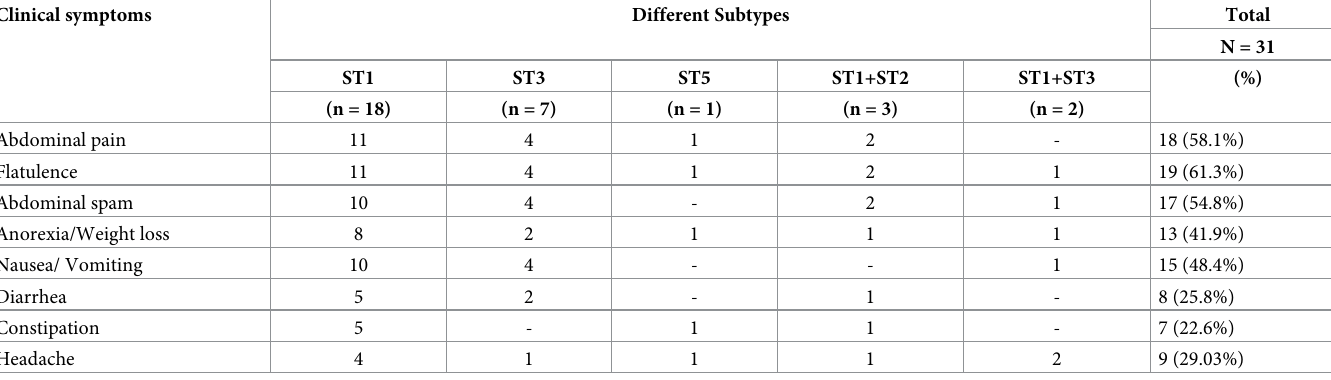
Table 3. The clinical symptoms relevant to the Blastocystis subtypes